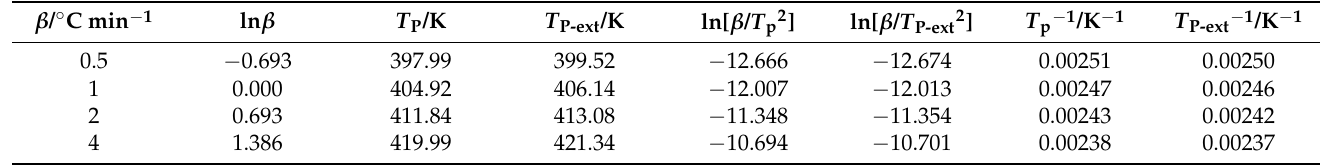
Table 6. Relevant parameters for BTBPC simulation analysis tests using the Kissinger